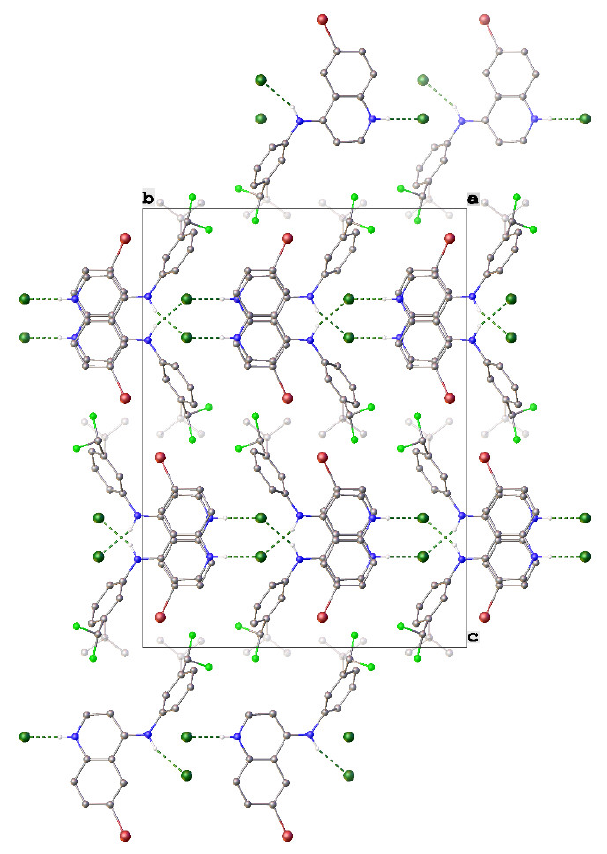
Figure 4. Unit cell contents of 8H + Cl − shown in projection down the a -axis. Hydrogen atoms except those involved in H-bonding are omitted for clarity. Hydrogen bonds are shown as dashed green lines. Minor disorder components are shown “ghosted”.